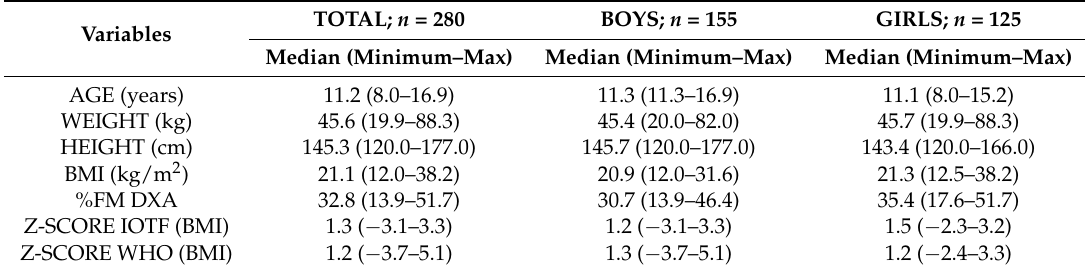
Table 1. Characteristics of sample of Chilean children and adolescents by sex.